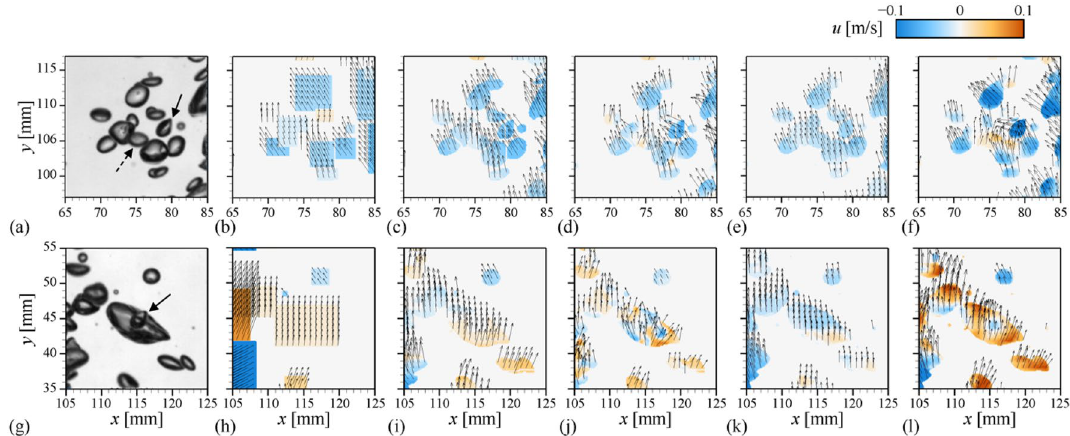
Figure 9. Instantaneous velocity field with the horizontal velocity contour for the local areas highlighted in Fig. 8a: ( a,g ) raw image; ( b,h ) PTV; ( c,i ) Lukas-Kanade; ( d,j ) Farnebäck; ( e,k ) pre-trained CNN-based model; ( f,l ) fine-tuned CNN-based